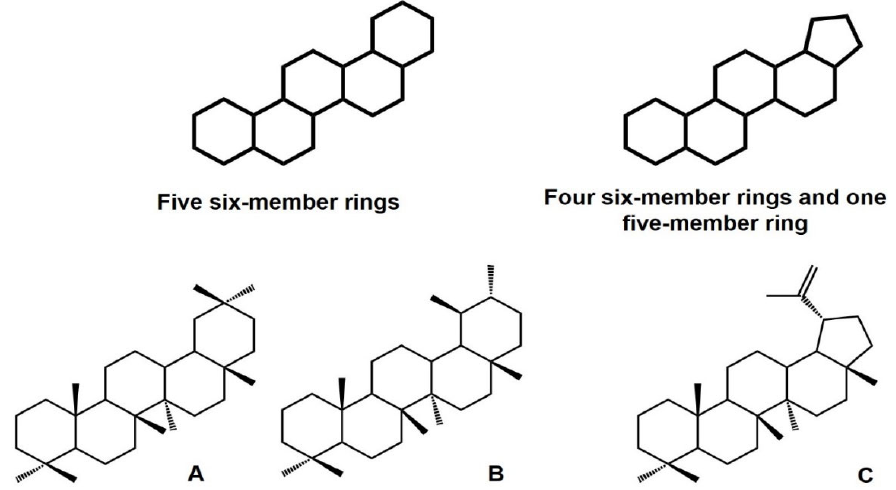
Figure 1. Pentacyclic triterpene backbone classification and representative subgroups: oleanane ( A ), ursane ( B ), and lupane ( C ).